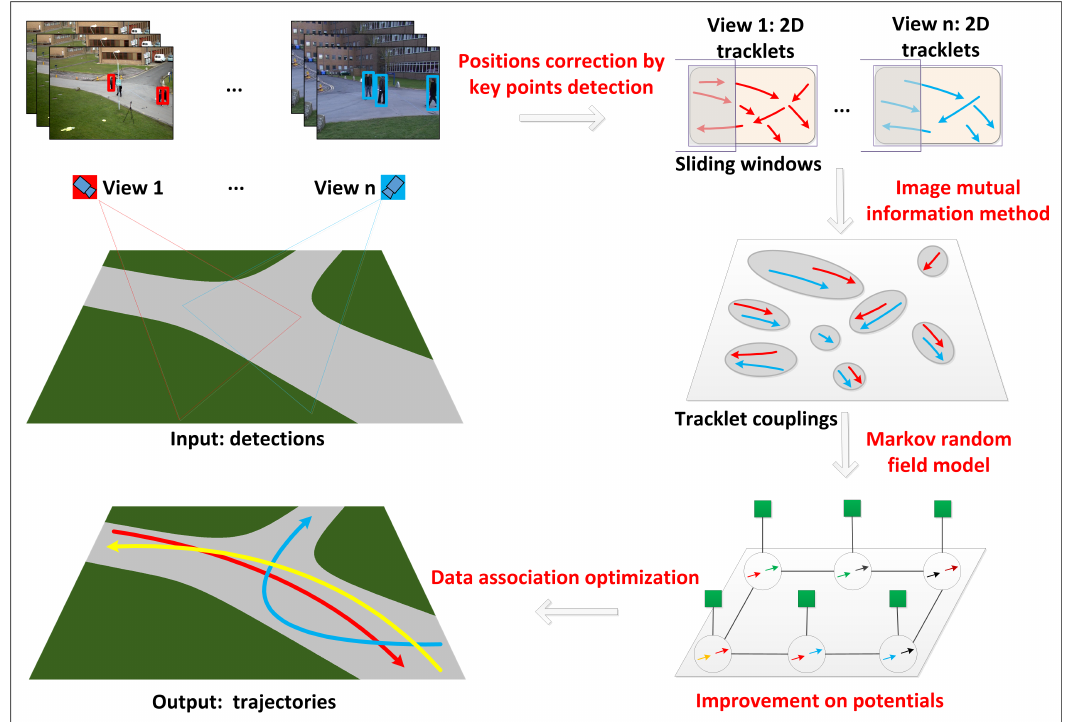
Figure 4. Framework of the proposed multi-view object tracking model, including position correction, tracklet building, cross-view tracklet coupling generation, the Markov random field model, potential function improvement, data association optimization, and the trajectories generation